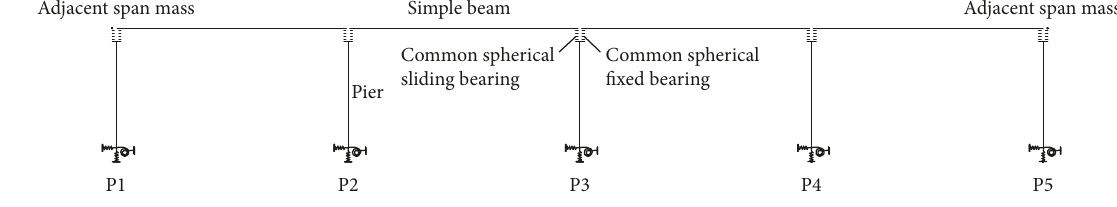
Figure 3: Stick model of the multi-span simply-supported HRB400 reinforcement bar with a diameter of 32 m was used, and the reinforcement ratio was 1.63%, as shown in Figure 7. For the longitudinal earthquake, the largest stress of the concrete and steel rebar is 13.5 MPa and 300.0 MPa, of the concrete and steel rebar is 15.9 MPa and 308.9 MPa, respectively.